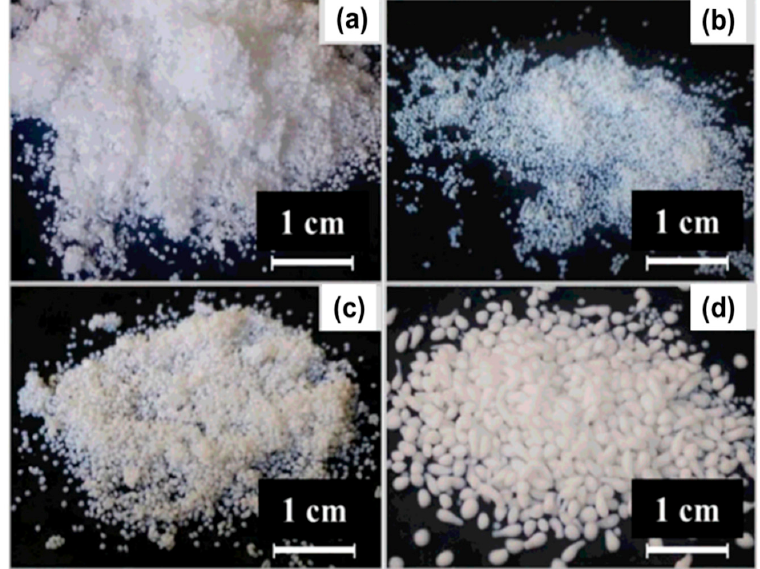
Figure 11. Cellulose aerogel beads from 2 wt % ( a – c ) and 3 wt % ( d ) cellulose-[DBNH][CO 2 Et] solutions coagulated in water ( a ), isopropanol ( b ) and ethanol ( c , d ); reproduced with permission from reference [175].